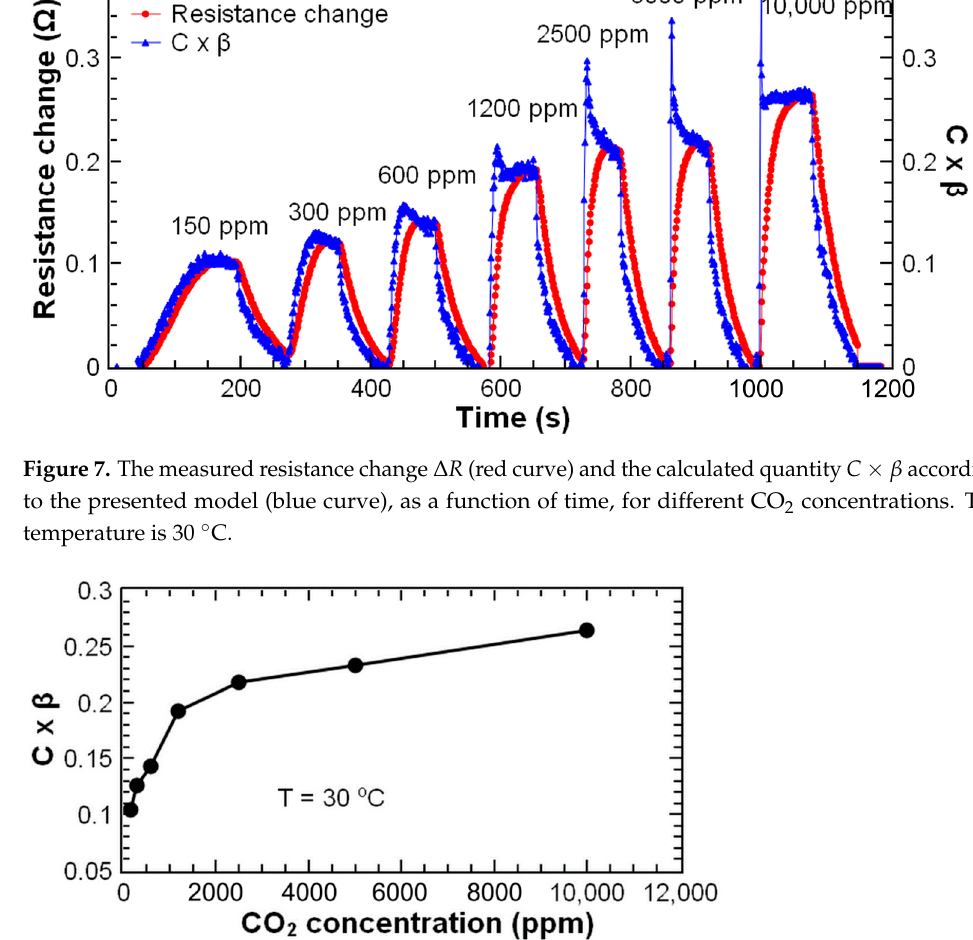
Figure 8. Quantity C β obtained experimentally as a function of the actual gas concentration.